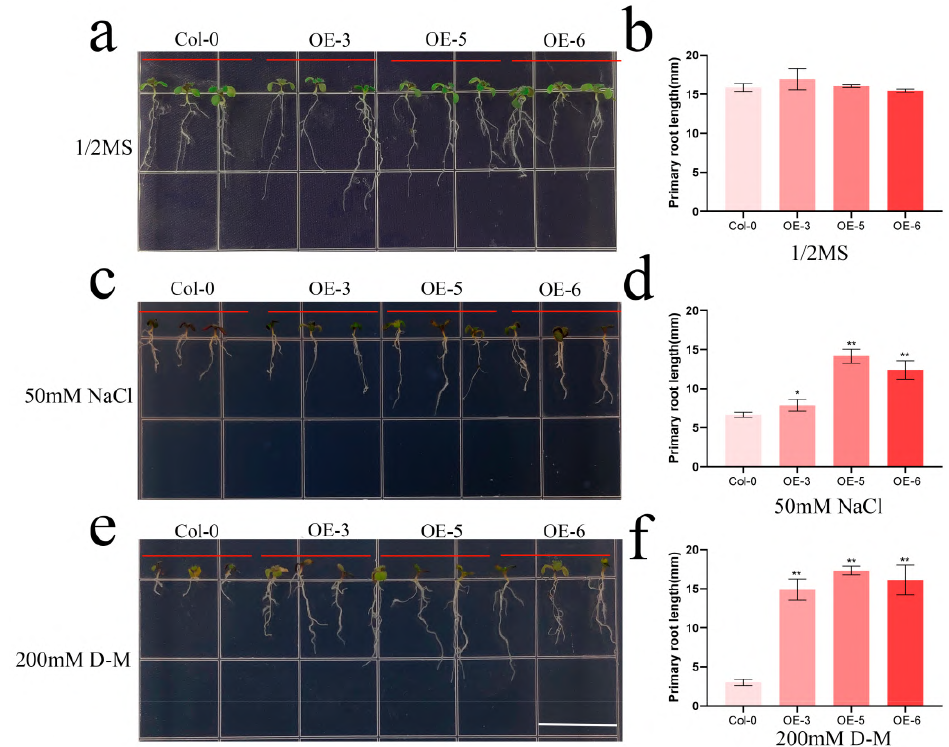
Figure 9. Effects of salt and drought stress on root length of wild-type (col-0) and Arabidopsis overexpressing HhbHLH2 (OE-3, OE-5, and OE-6). ( a ) Three-day-old seedlings were transferred to MS medium for 7 days. ( b ) Root length statistics in MS medium. ( c ) Three-day-old seedlings were transferred to MS medium in 50 mM NaCl for seven days. ( d ) Root length statistics in 50 mM NaCl for seven days. ( e ) Three-day-old seedlings were transferred to MS medium in 200 mM D-M for 7 days. ( f ) Root length statistics in MS medium 200 mM D-M for 7 days. Asterisks indicate the corresponding gene significantly up- or down-regulated compared with the untreated control (* p < 0.05, ** p < 0.01, Student’s t